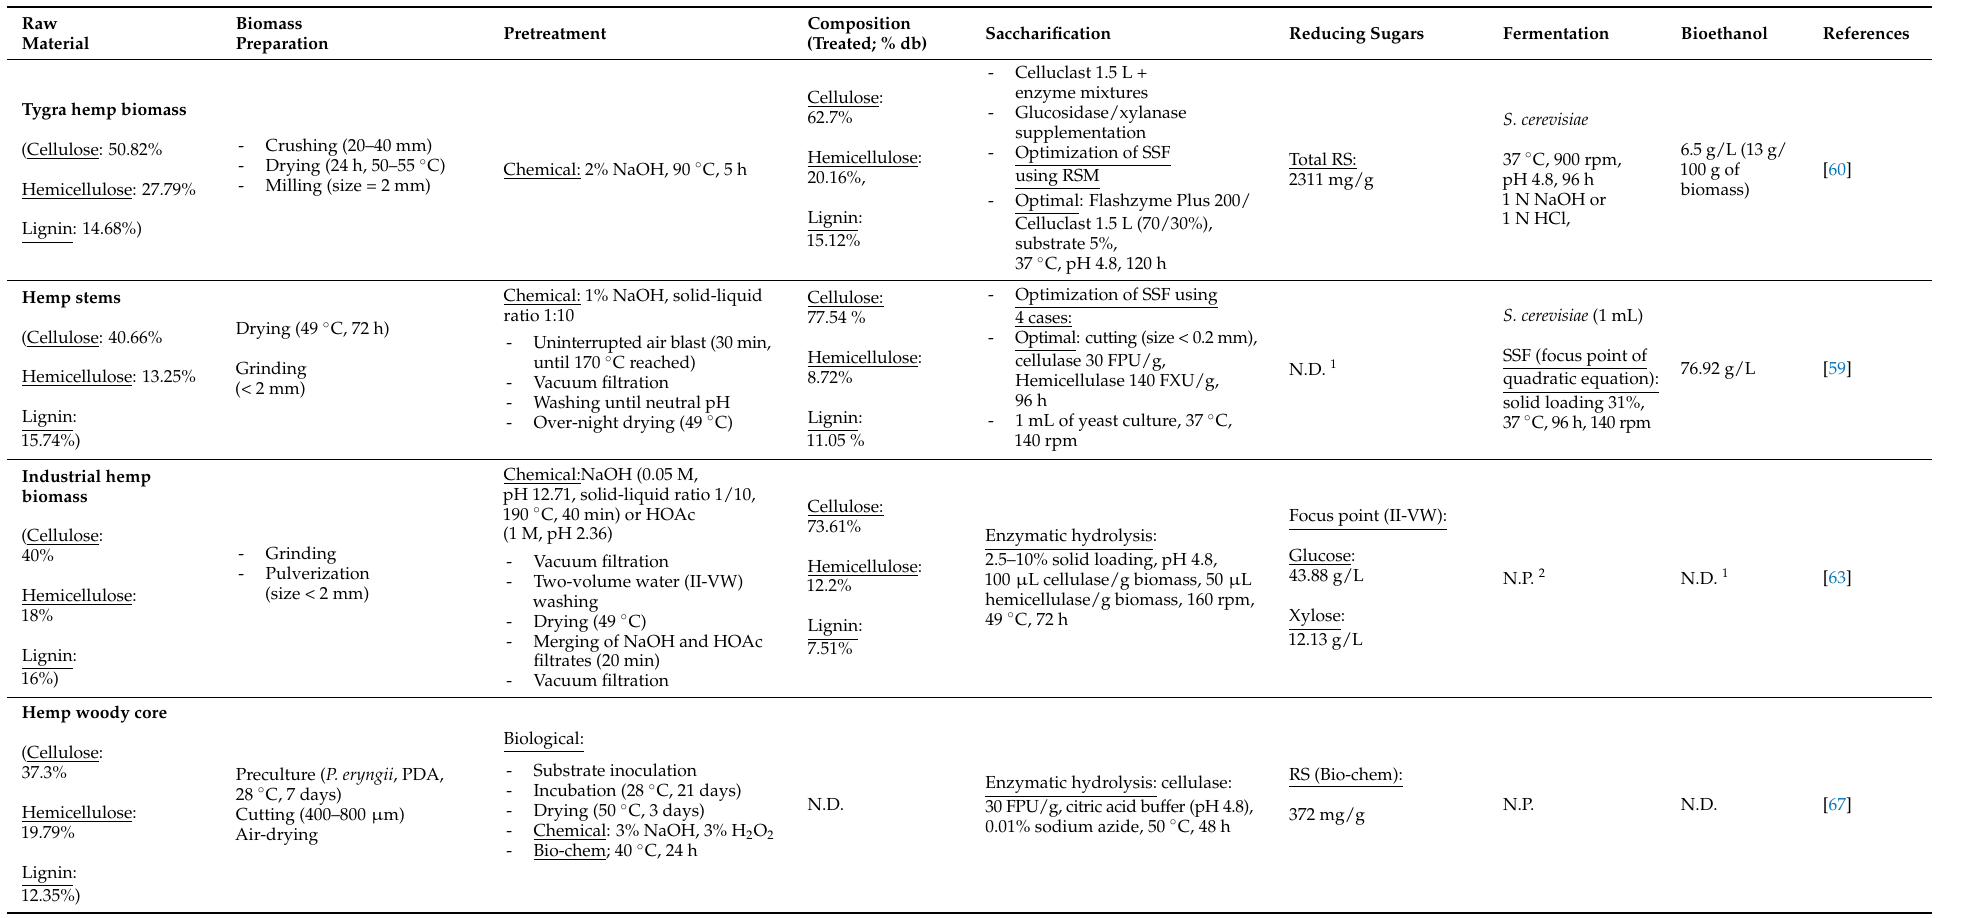
Table 2. Summary of the recent experiments done for pretreatment of hemp